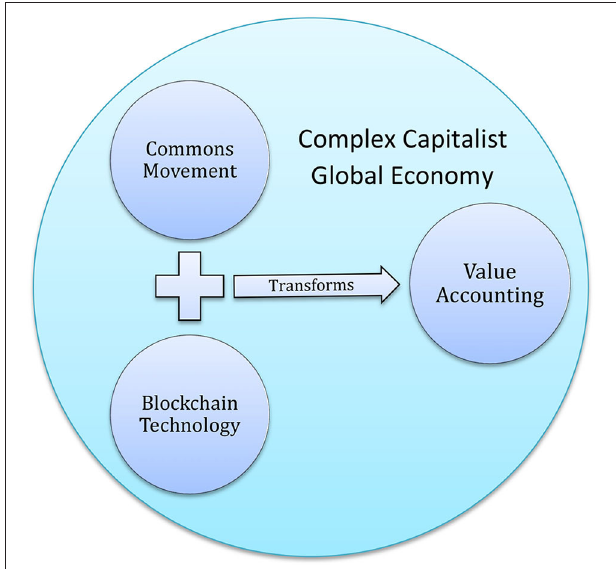
FIGURE 1 | Transformation occurring within capitalism as social movements combine with new